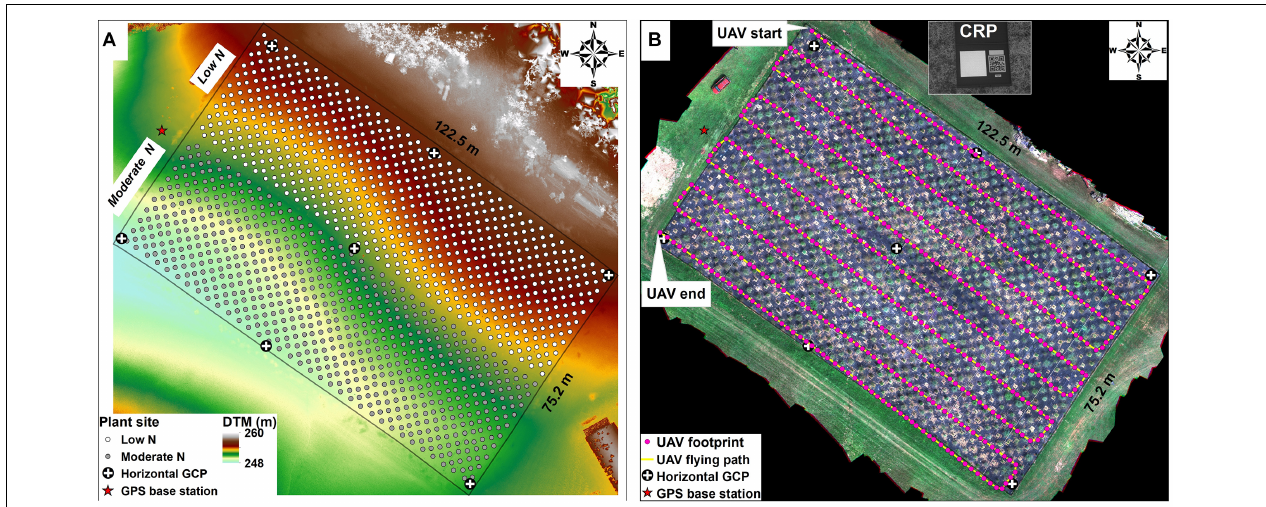
FIGURE 2 | UAV ground control and flight operations. (A) Bare ground elevation data (i.e., digital terrestrial models, DTM) obtained after the switchgrass harvest (January 21, 2020) using UAV-based LiDAR scanning technology. The UAV ground control system included a GPS base station used for post-processing differential correction of LiDAR point clouds, horizontal GCP used for geometric rectification of multispectral image. Shown is the planting site for the 1,320 switchgrass plants. (B) UAV route over the field, as well as the calibrated reflectance panel (CRP) used to convert raw pixel values from multispectral images to absolute reflectance, where the CRP image was obtained before or after the